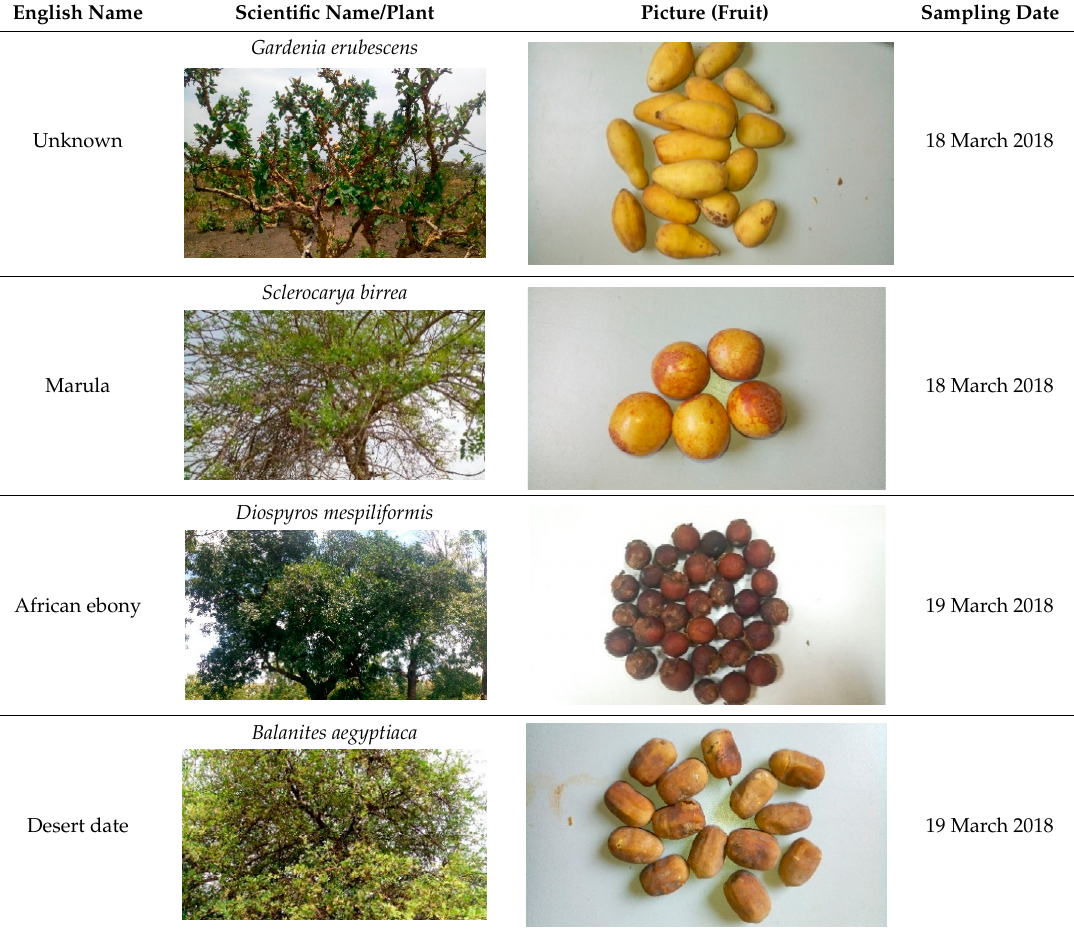
Table 1. Names, pictures, and sampling dates of the fruit samples used for the study.